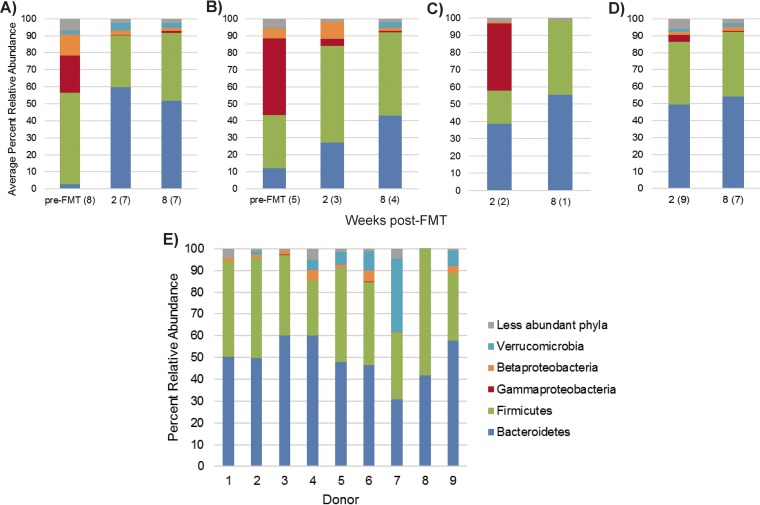
Distribution of phyla in patient and donor fecal samples. (A to D) Distribution of phyla in fecal samples from patients cured by heterologous FMT (A) or autologous FMT (B) and patients who had recurrence following autologous FMT (C) and received a follow-up heterologous FMT (D). (E) Distribution of phyla in samples from individual donors. The numbers within parentheses reflect sample sizes, and phylum percentages were averaged among patient samples.